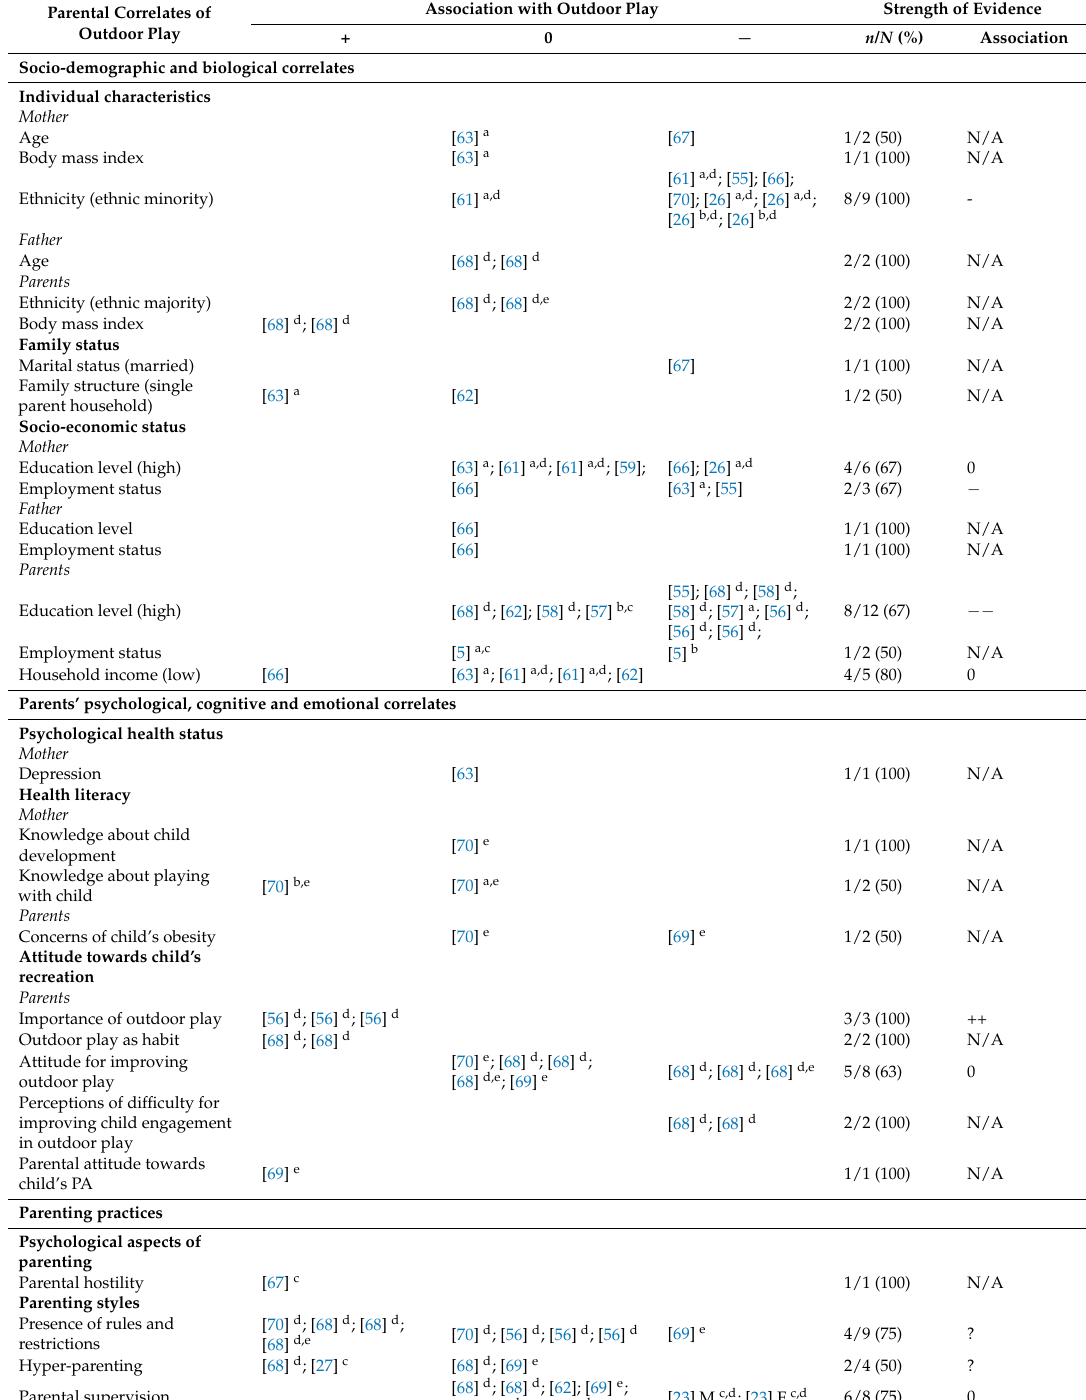
Table 3. Parental correlates of outdoor play in